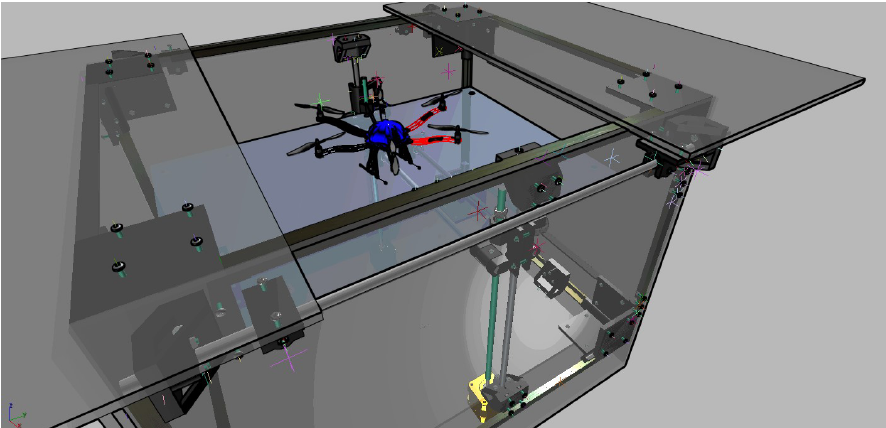
Figure 5. Charging